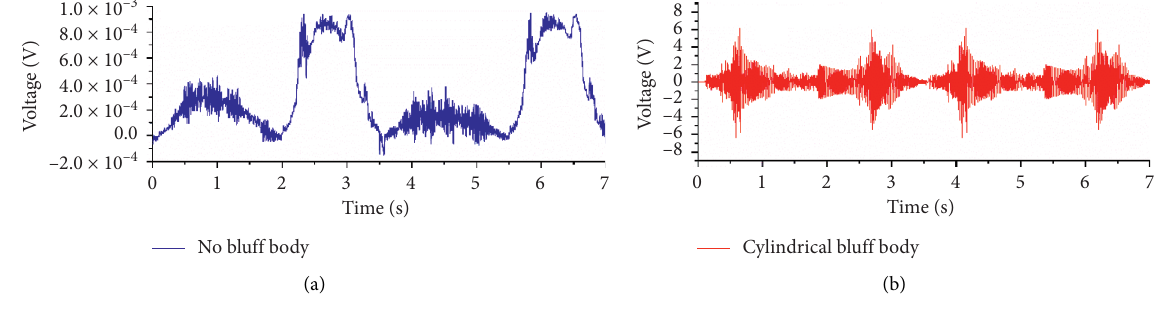
Figure 14: The voltages on the piezoelectric cantilever beam.